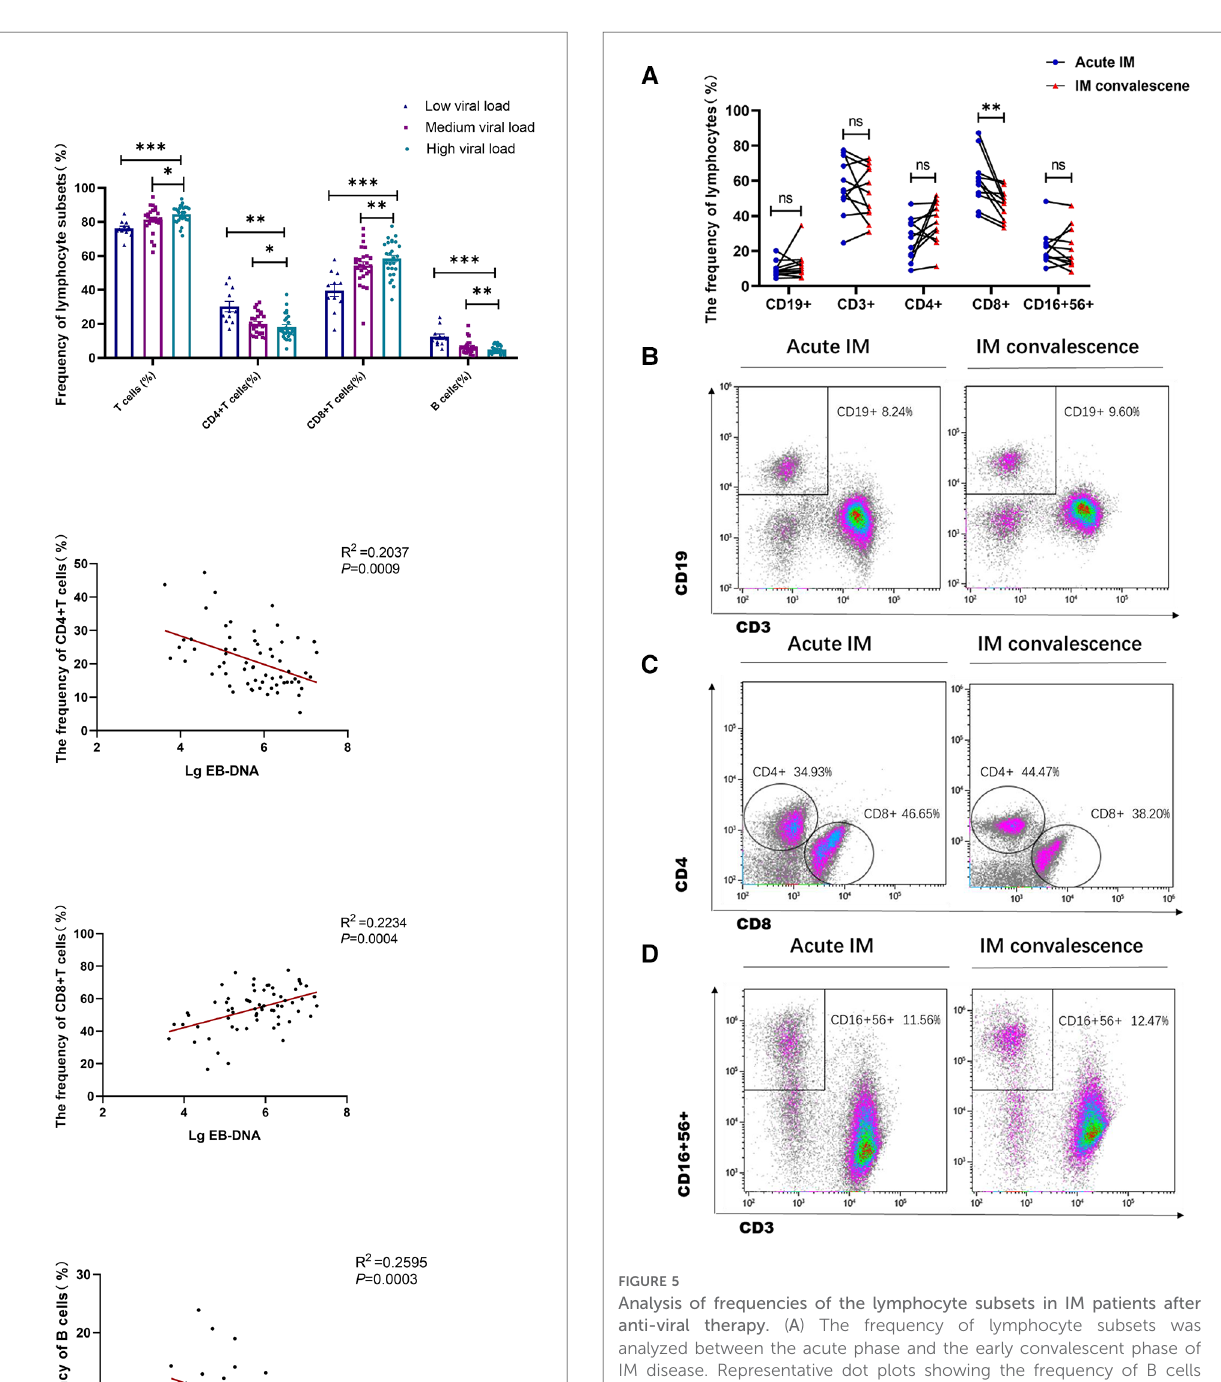
various individuals ( Figure 8 ). The overall analysis of immune signatures showed that the AST level, the frequency of CD8 + T cells, and proportion of effector subsets in CD4 + and CD8 + T cells increased, whereas CD62L expression on CD4 + and CD8 + T cells decreased in the AIM group compared with the HC and convalescent group. Taken together, these results suggested that the immune environment, including in fl ammation, lymphocyte subsets and immune response, tended to normalize during the convalescent phase in patients with IM after antiviral therapy.